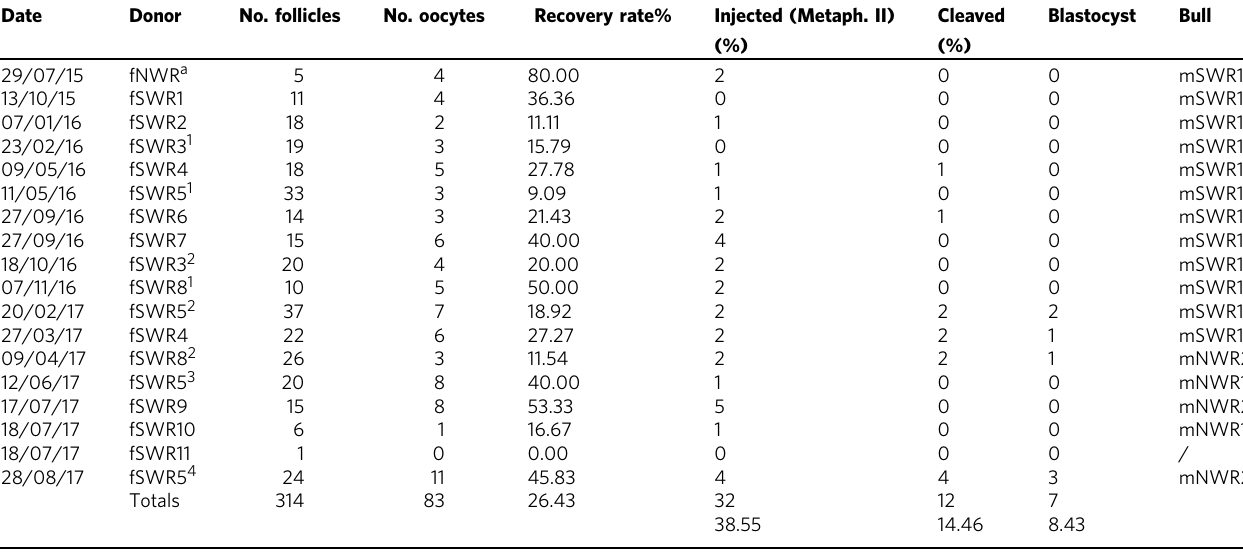
Superscripts indicate the number of repeated OPU on the same donor a Oocytes were harvested from the ovaries after the natural death of the animal being the only NWR female used